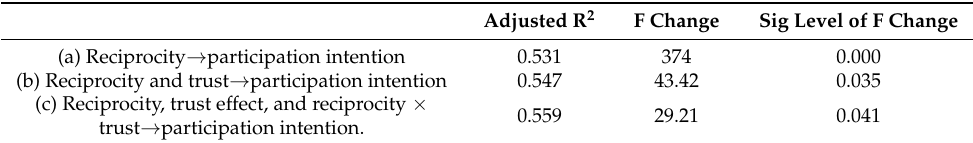
Table 7. The results of moderating effect of trust on participation intention.